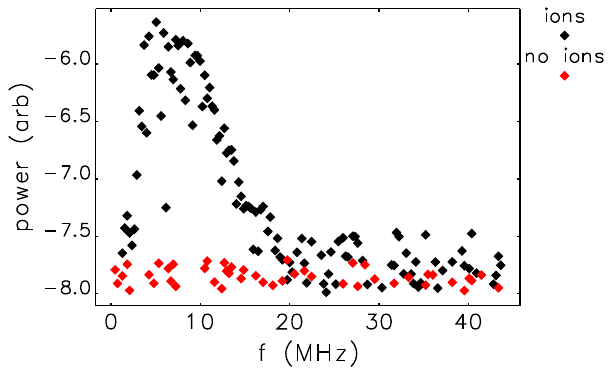
FIG. 5. Amplitude of lower vertical betatron sidebands in the baseline simulation, compared to a simulation with no